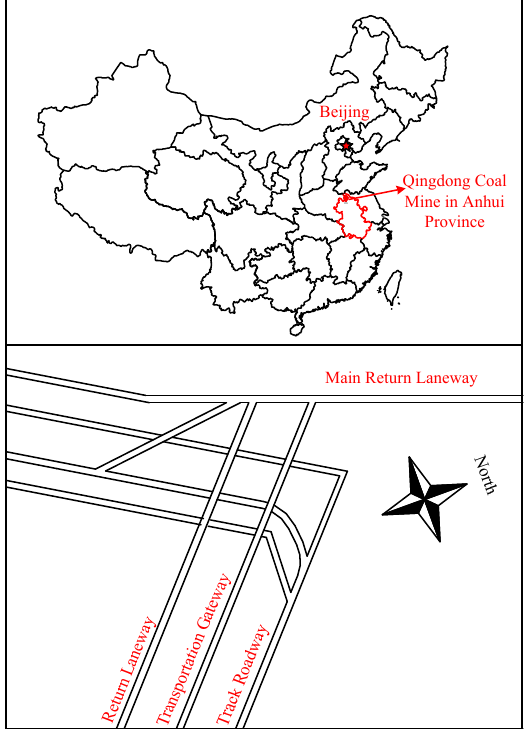
Figure 6. Location of the main return laneway.